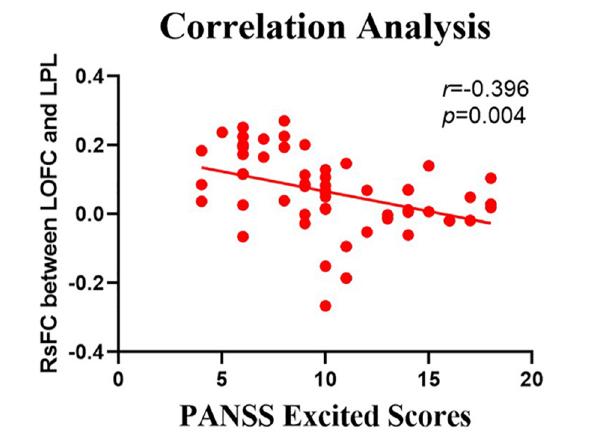
FIGURE 3 | Negative correlation between the resting-state functional connectivity (rsFC) values and the severity of excited symptoms in the FES. The X-axis is the score of the excited factors of the PANSS scale, and the Y-axis shows the functional connectivity of the left orbitofrontal cortex (LOFC) and left paracentral lobule (LPL) (after correcting for positive symptoms, age, gender, education, and illness duration).